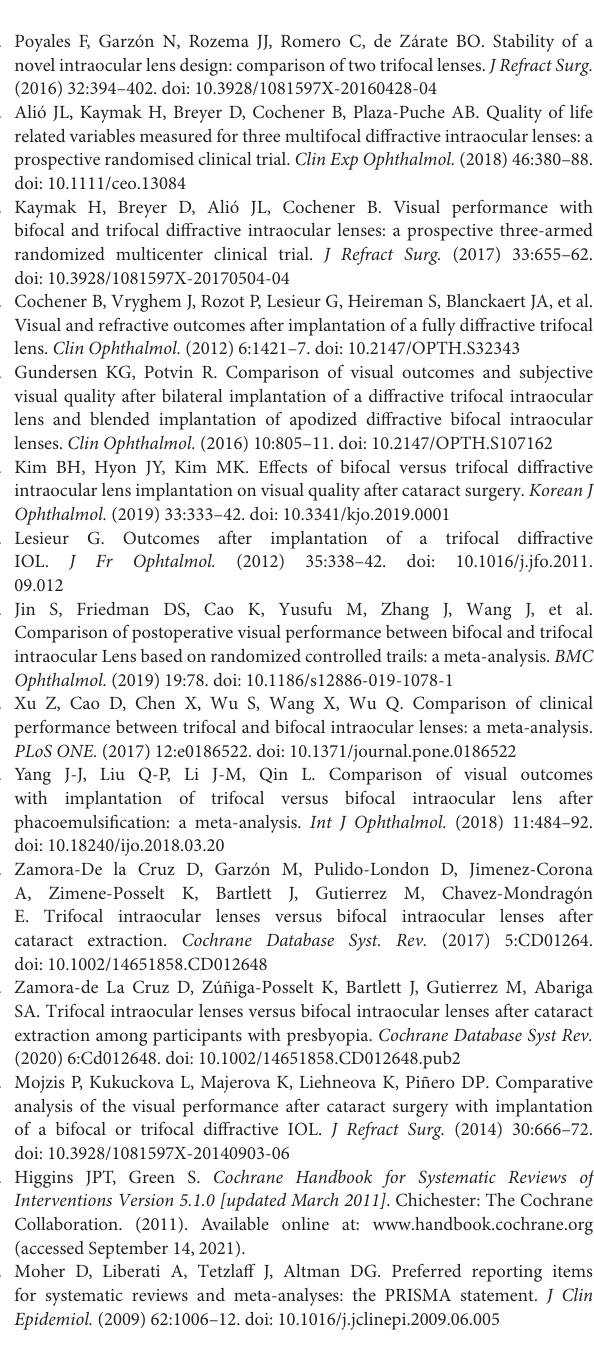
Supplementary Figure S6 | Subgroup analysis of distant-corrected DVA according to IOL types. SD, standard difference; IV, inverse variance; CI, confidence interval; DVA, distant visual acuity; IOL, intraocular lens. Experimental and control indicate trifocal and bifocal IOLs, respectively. Supplementary Figure S7 | Meta-analysis of secondary outcomes including residual sphere (A) , spherical equivalence (B) , residual cylinder (C) , PCO (D) , spectacle independence (E) , and complications (F) . M-H, Mantel-Haenszel; IV, inverse variance; CI, confidence interval; PCO, posterior capsular opacification. Experimental and control indicate trifocal and bifocal IOLs,